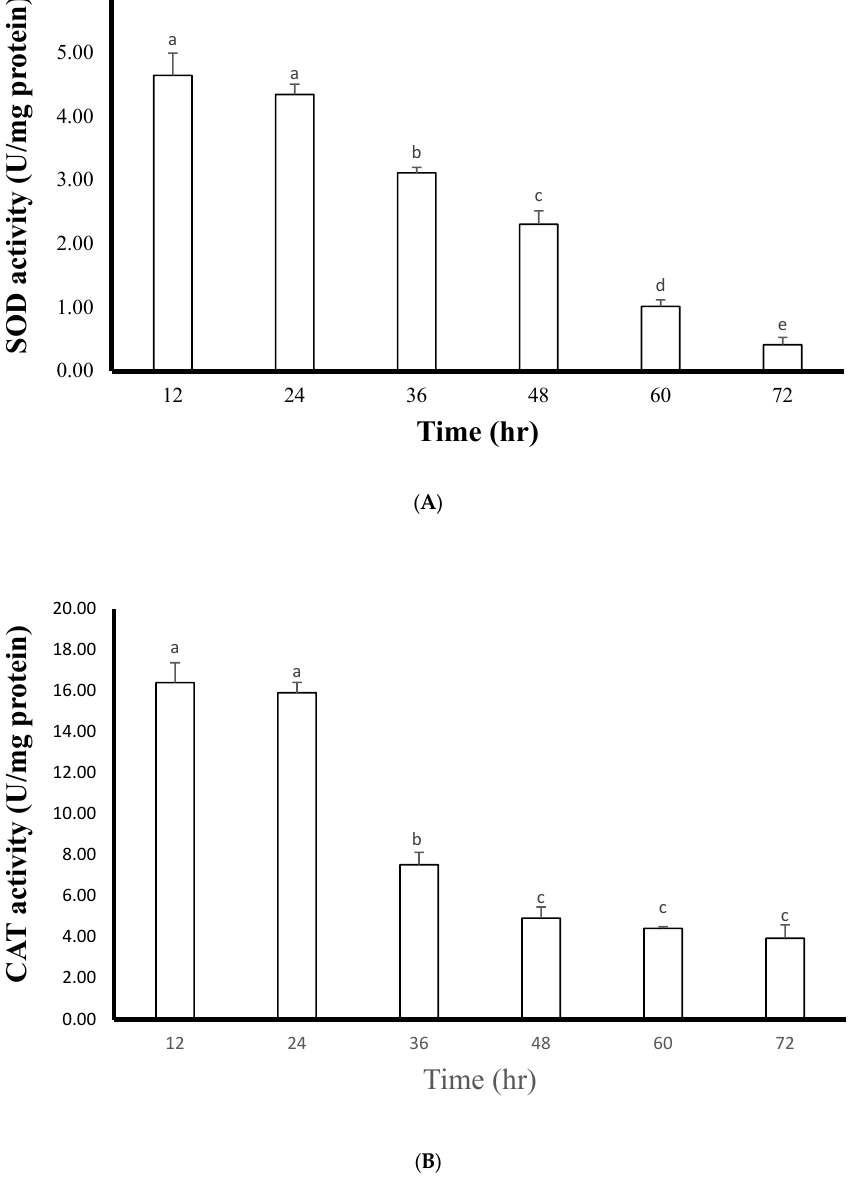
Figure 2 . Effects of the SOD and CAT activities on coral infected with ciliate within 72 h. Different letters indicate significant differences among groups ( p < 0.05). The values are expressed as means ± SDs (n = 30 colonies). ( A ): indicates SOD, ( B ): indicates CAT.